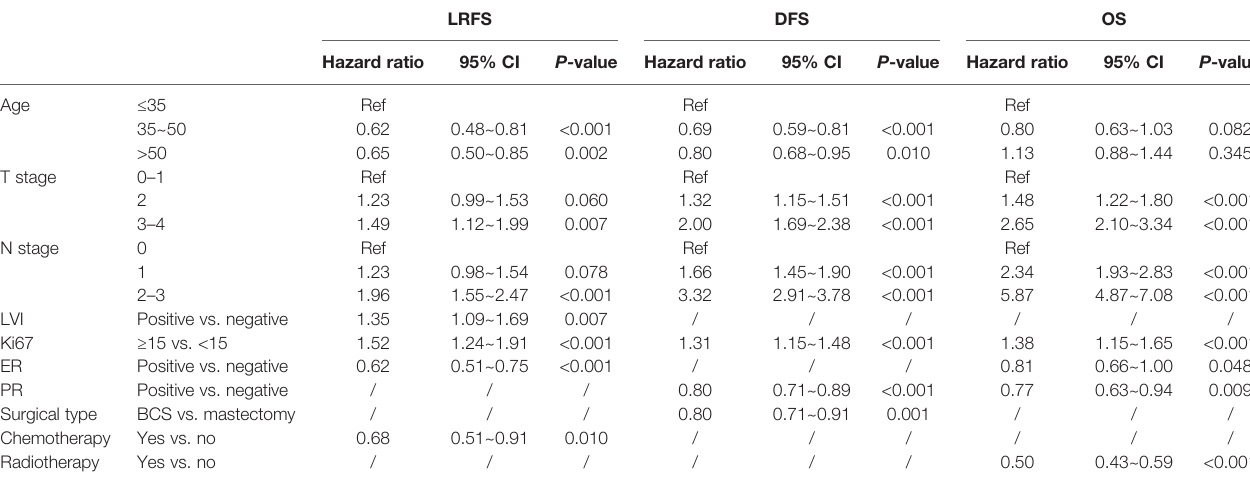
TABLE 4 | Multivariable survival analyses strati fi ed by age, adjusted for clinicopathological